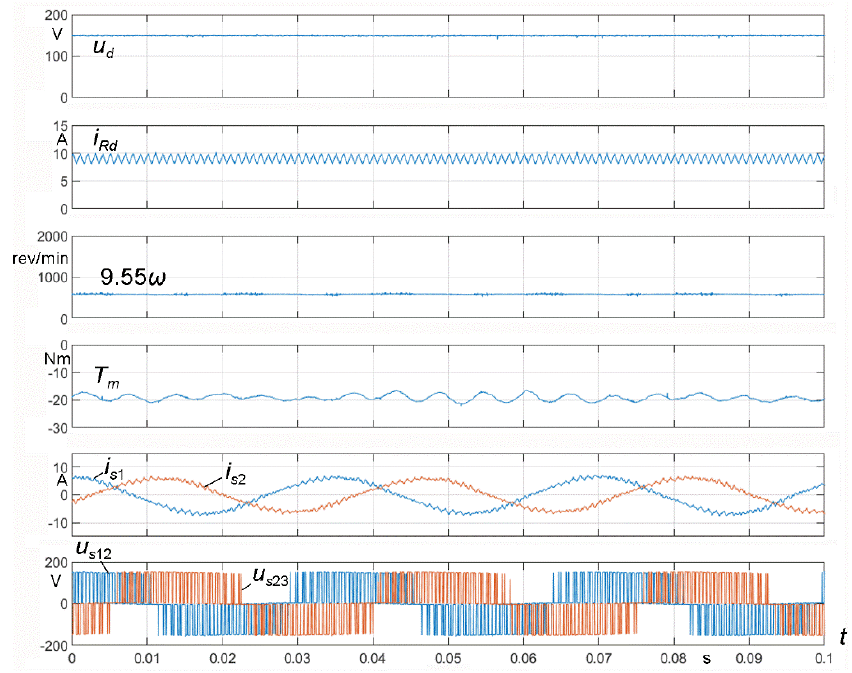
Figure 14. Steady-state waveforms corresponding to case A in Figure 13 at Ω pu = 0.3, m = 3.